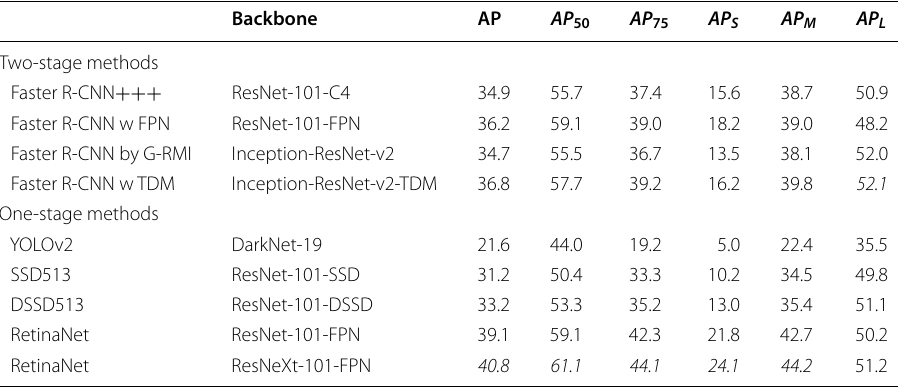
Italic scores indicate top AP performances